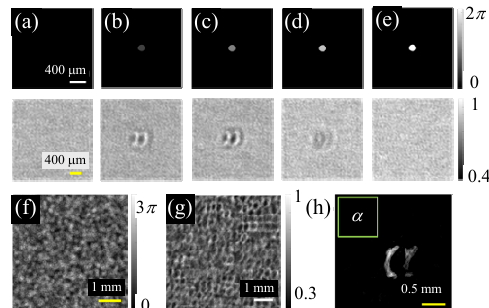
Fig. 3 Simulation results of randomly packed phase pinhole cameras: (a)–(e) the upper row illustrates phase screens with only one circular bump of uniform phase (0,  /2,  , 3  /2, and 2  , respectively) at the center; the lower row is the corresponding intensity patterns on the detection plane; (f) an example of phase screen with 10 4 randomly distributed phase bumps within a field of view of 5×5 mm 2 . The phase step height of each pinhole is  /8; (g) the corresponding light pattern after normalization; (h) the reconstructed